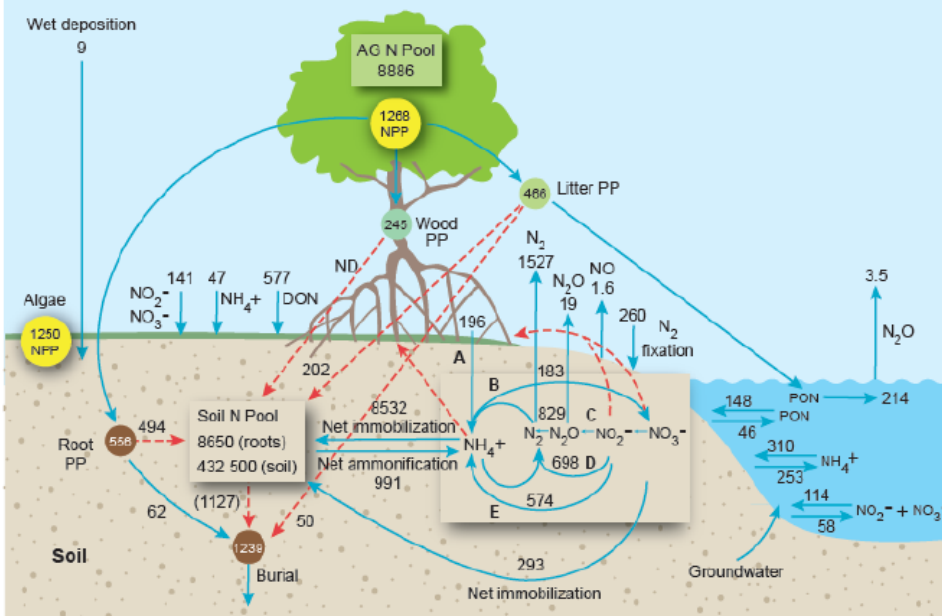
Figure 2. N cycling in mangrove ecosystems. Mean fluxes = g N ha − 1 d − 1 ; mean standing stocks = g N ha − 1 . Soil N transformations are lettered as (A) root + rhizome N 2 -fixation, (B) net nitrification, (C) denitrification, (D) anammox, and (E) dissimilatory nitrate reduction to ammonium. Dashed red arrows represent means estimated by difference; solid blue arrows are empirical means. The roots and soil pool (box to left in the forest floor) is to a depth of 1 m. N transformations in soil are to depths of 5–20 cm as presented in box on right in the forest floor. Abbreviations: ND = no data, AG N Pool—aboveground forest N biomass pool, PP = primary production; NPP = net primary production. Modified from [9]. Reproduced under the terms and conditions of the Creative Com- mons Attribution (CC BY) license (http://creativecommons.org/licenses/by/4.0/). Accessed on 10 April 2021.